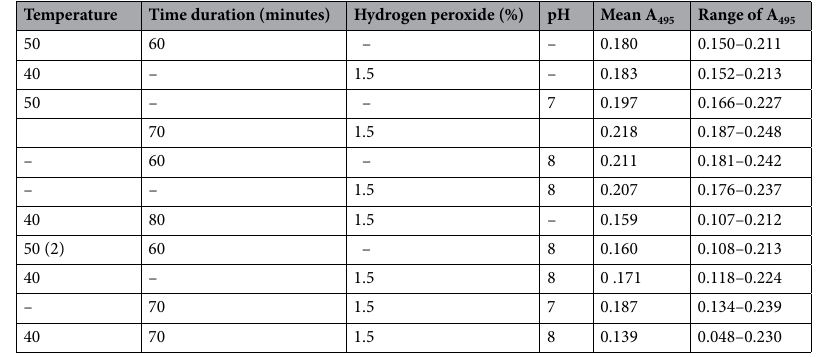
Table 3. Effect of combination of temperature, duration of treatment, percentage hydrogen peroxide and pH on decolorization of biosurfactant solution. The data presented in this table are based on full factorial analysis.